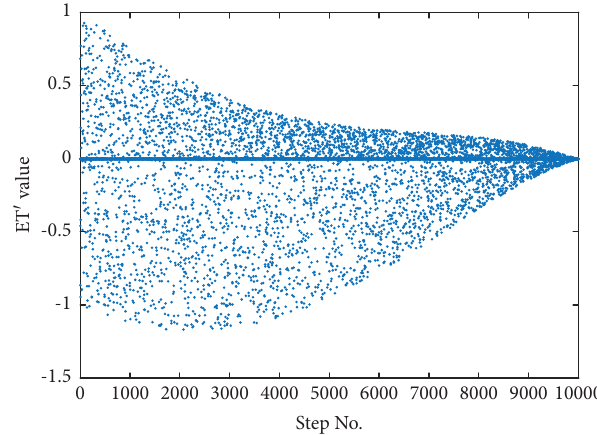
Figure 3: Te maximum and minimum values of ET ′